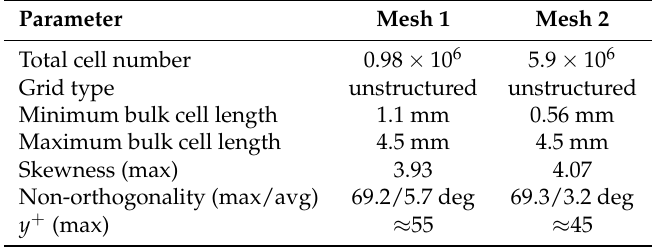
Table 3. Main parameters of the computational grids for the fixed intake valve